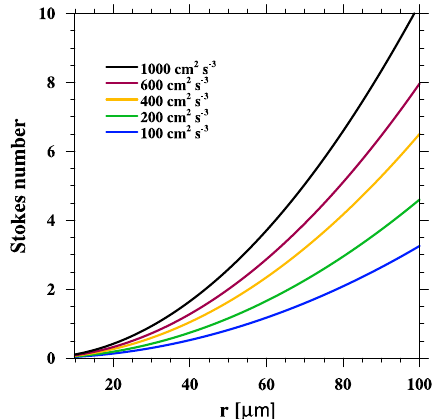
Figure 1. Stokes number against the particle radius for various en- ergy dissipation